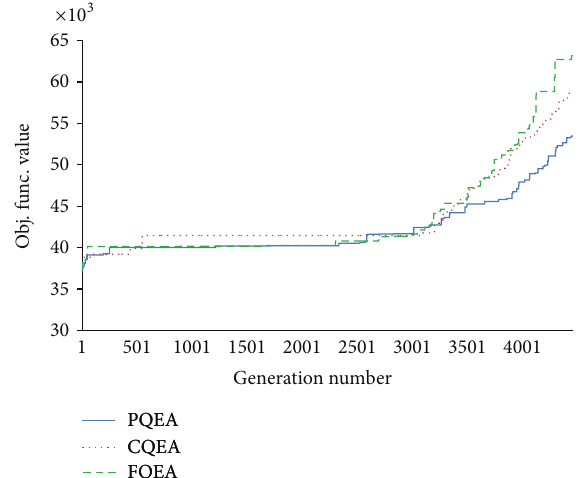
Figure 26: Convergence graph of PQEA, CQEA, and FQEA on 0-1 knapsack problem with multiple strongly correlated data instances with number of items, 𝑀 , being 5000 and capacity, 𝐶 , being 1% of total weight.